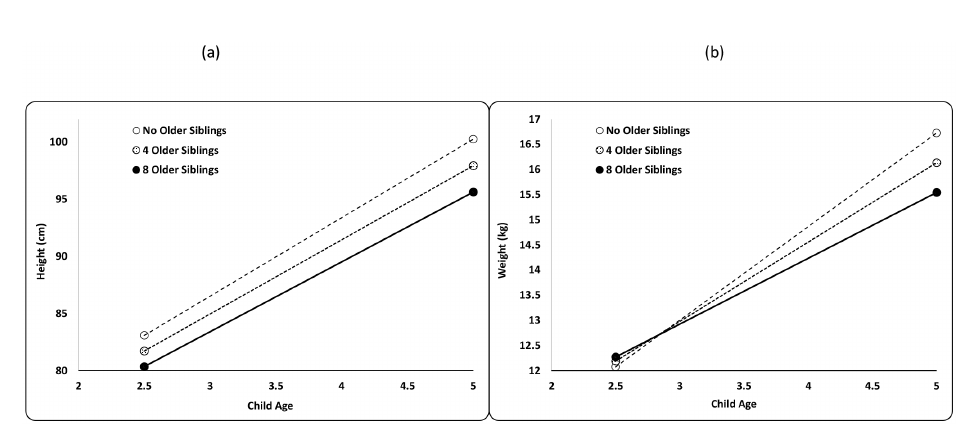
Fig 3. Growth performance stratified by the number of older siblings (OS) for Maya children ages 2.5 – 5.0. Lines plot (A) predicted height (cm) for boys and girls, and predicted weight (kg) for (B) boys and girls with 0, 4 and 8 older siblings (drawn from S1 Table Models 3a-c).